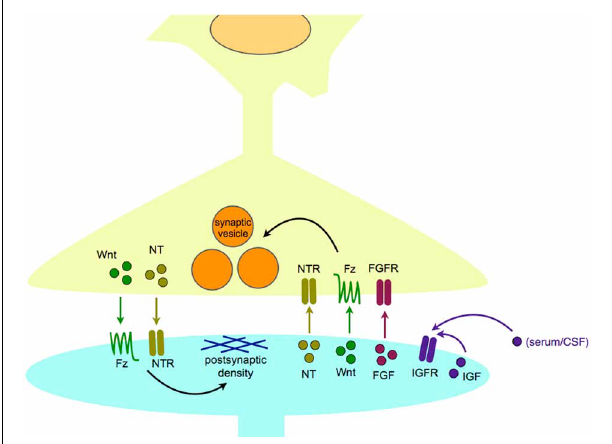
FIGURE 2 | Synaptogenic growth factors in normal synapse formation and maintenance. Synaptogenic growth factors, including neurotrophins, Wnts, and FGFs, are secreted from the postsynaptic cell to induce appropriate differentiation of the presynaptic terminal, including clustering of synaptic vesicles. In turn, growth factors, including neurotrophins, and Wnts, can be released from the presynaptic cell to organize the differentiation of the postsynaptic density. IGFs are thought to act in a paracrine or autocrine fashion, and may be able to bind receptors within the synapse as well as at extrasynaptic sites. Abbreviations used: FGF, fibroblast growth factor; FGFR, fibroblast growth factor receptor; Fz, Frizzled receptor; IGF, insulin-like growth factor; IGFR, insulin-like growth factor receptor; NT, neurotrophin; NTR, neurotrophin